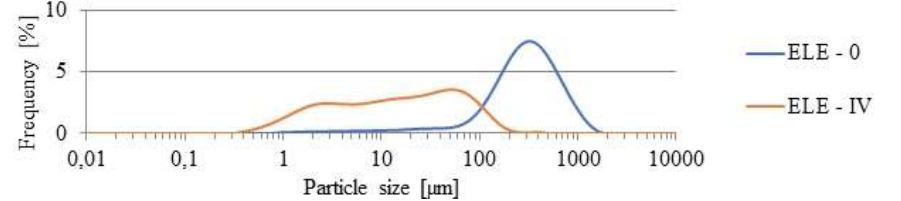
Figure 2. Fly ash granulometry – frequency of particle size.